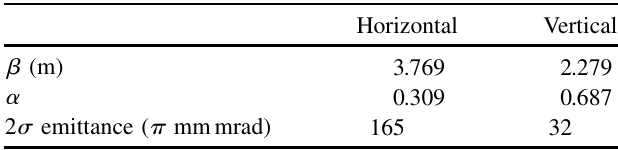
TABLE II. Initial values of beam